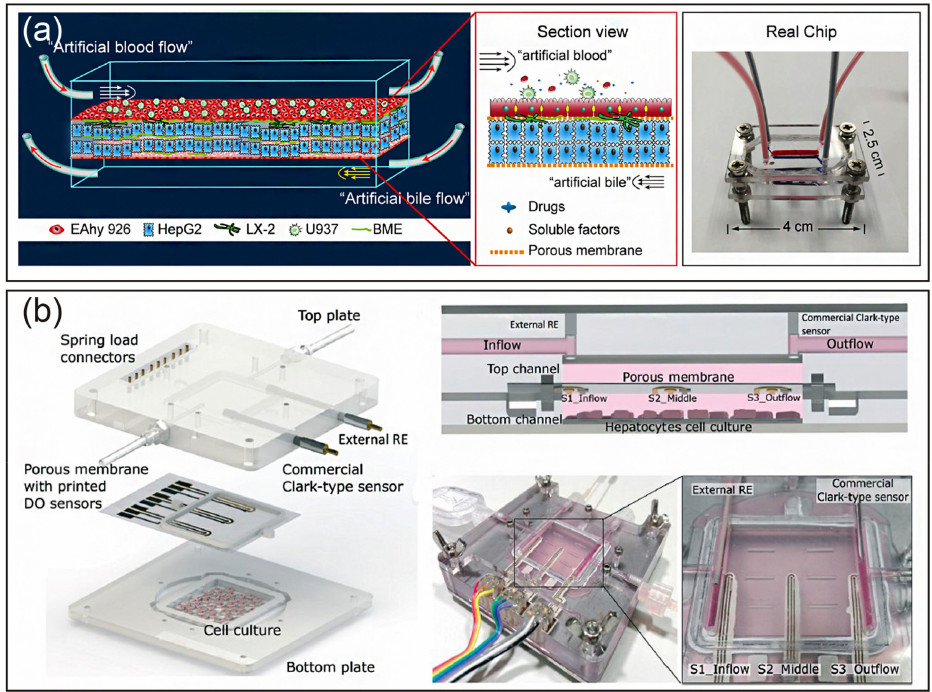
Figure 4. Establishment of a liver-on-a-chip using layer-by-layer deposition. ( a ) Schematic of the liver sinusoid structure and LSOC microdevice. Reproduced with permission from [31]. ( b ) Schematic, cross-section, and real image of an oxygen sensor-integrated liver chip. Reproduced with permission from